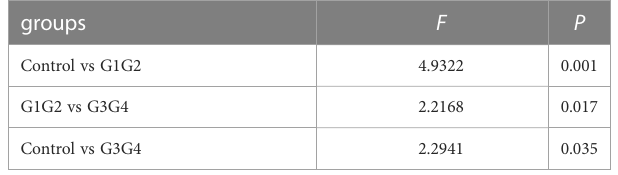
TABLE 5 Comparison of the top ten gut microbiota in relative abundance in the G1G2 and G3G4 groups at the phylum level.